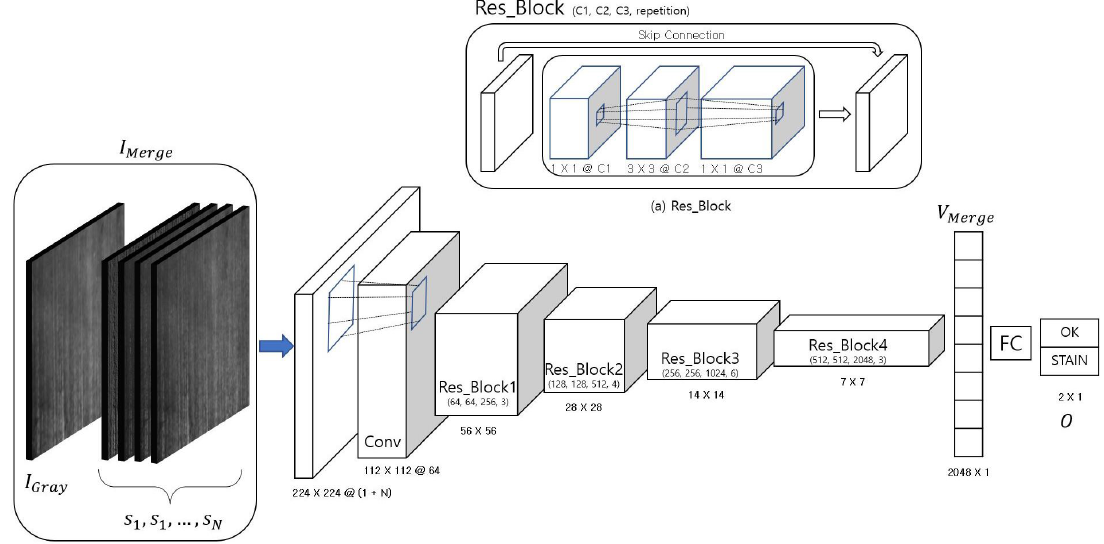
Figure 4. Single-stream network structure based on